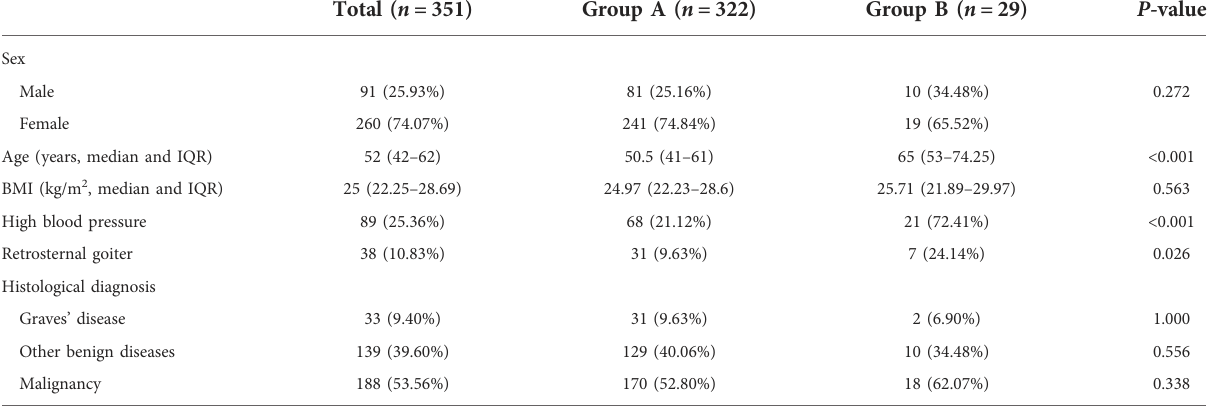
TABLE 1 Demographic data, preoperative features and histopathological fi